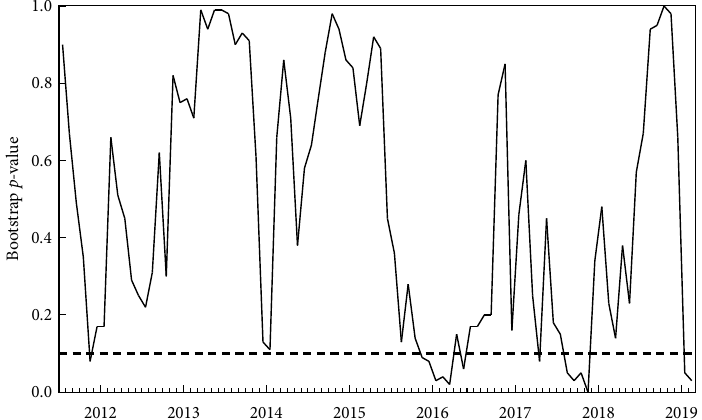
Figure 2. Bootstrap p -values of rolling test statistic testing the null hypothesis that PC does not Granger cause BP